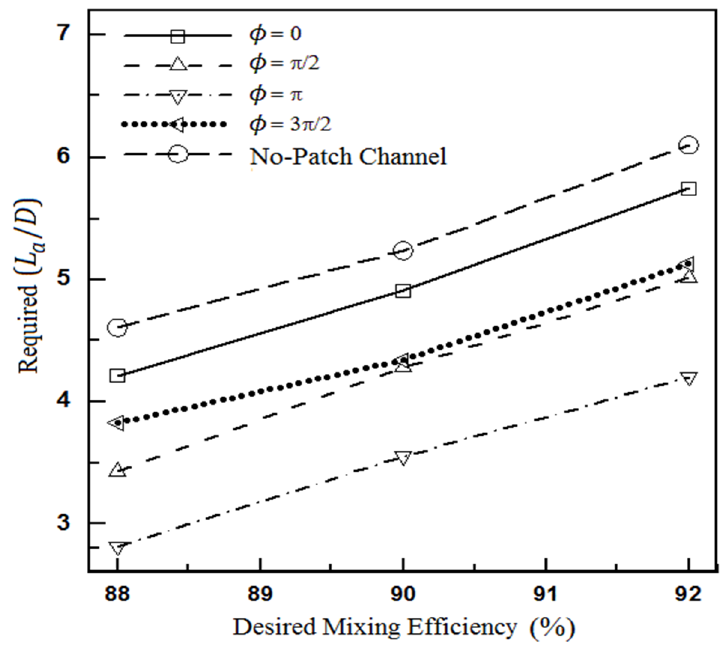
Figure 7. The length required to achieve the desired mixing efficiency for the flow fields of Equations (20) and (21).